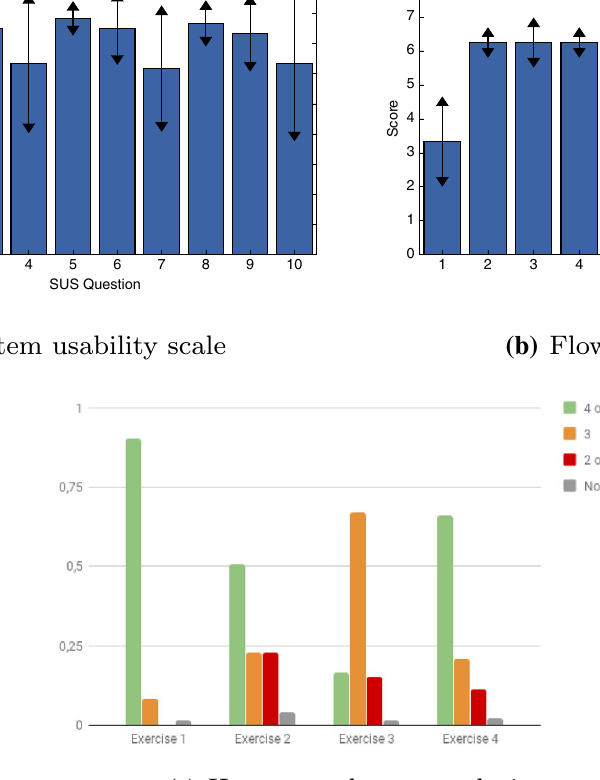
arrows representing the ±sigma range. Graph c represents, for each different exercise, the percentage of repetitions evaluated by the human evaluator with 4 or above, 3, 2 or lower, and not